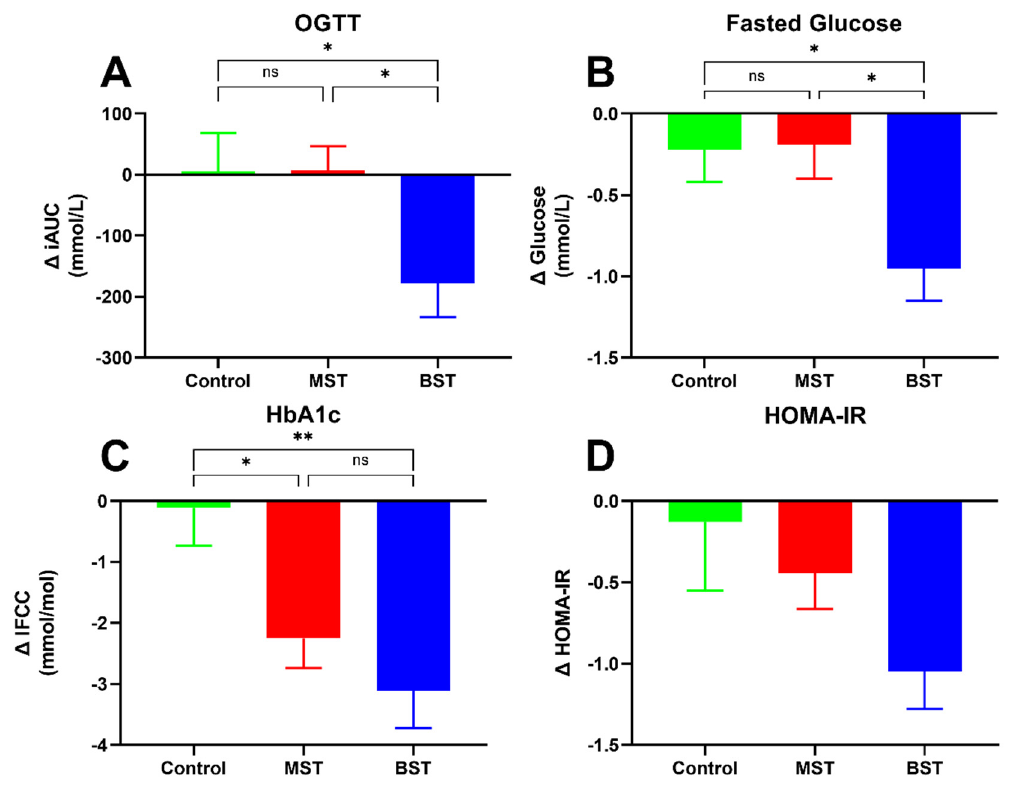
Figure 3. Change ( ∆ ) in ( A ) area under the curve (AUC) glucose (240 min) during the OGTT, ( B ) fasting glucose changes, ( C ) HbA1c changes, and ( D ) changes in HOMA-IR; after 12-week intervention. p < 0.05 (*); p < 0.001 (**).